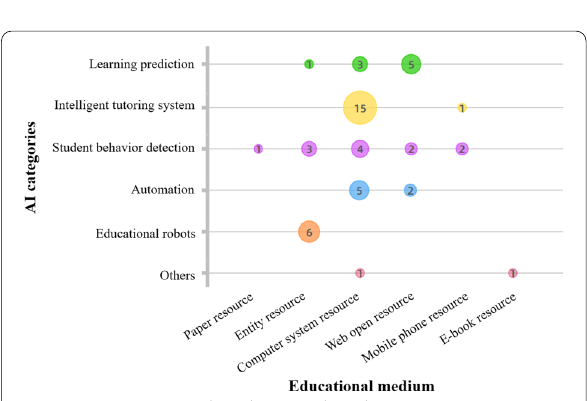
Fig. 9 AI categories under educational medium ( N